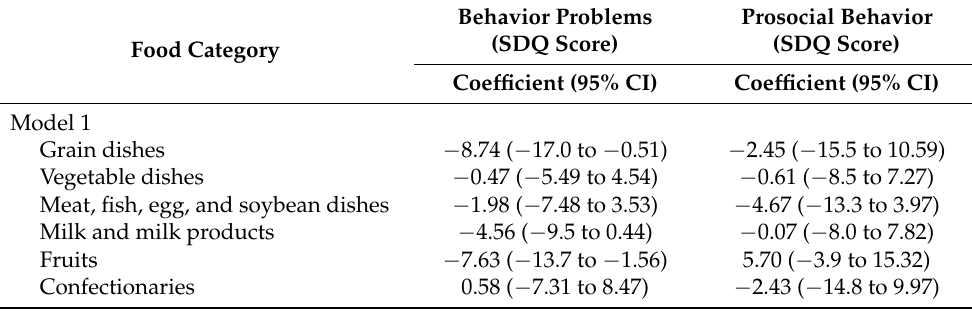
Table 3. Results of regression analyses on children’s mental health according to the frequencies of food categories for breakfast among Japanese school children ( n =